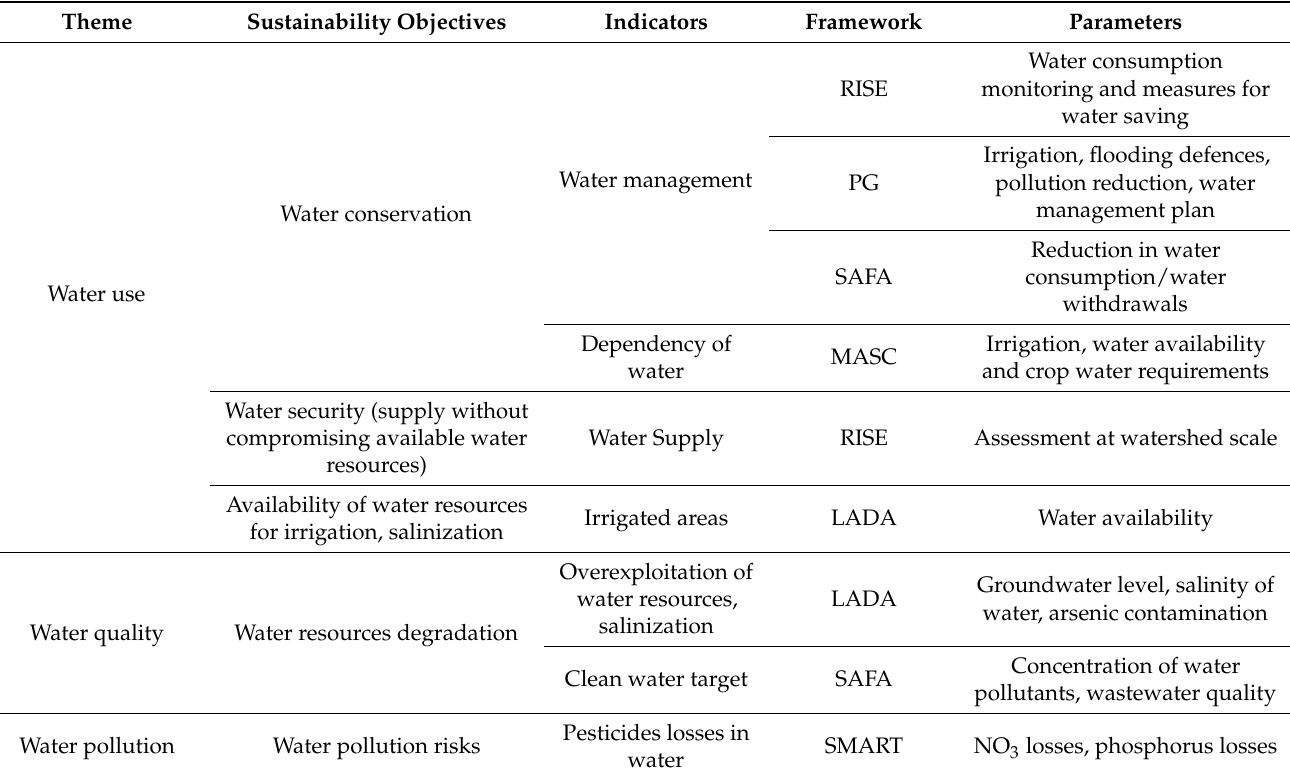
Table 2. Environmental themes, sustainability objectives, indicators and measured parameters for each framework considered in this